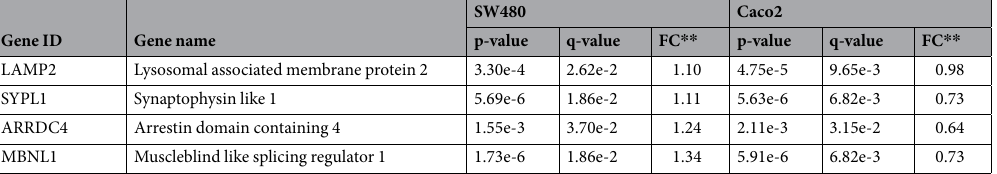
Table 1. Genes significantly deregulated in both the Caco2 and SW480 cell lines under AURKA knockdown (n = 54). p-value, q-value and log 2 fold change (FC) from the two differential mRNA expression analyses are shown for each gene ID. The Gene names are retrieved from Ensembl. The table is sorted on SW480 log 2 FC.